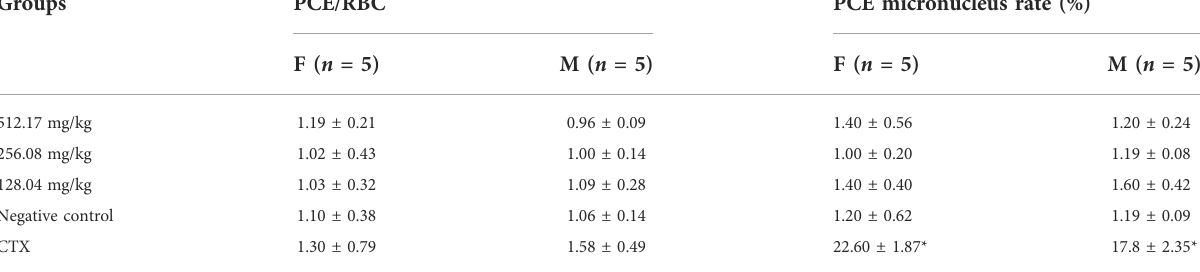
TABLE 7 Results of the micronucleus test in mouse bone marrow cells with MCE.